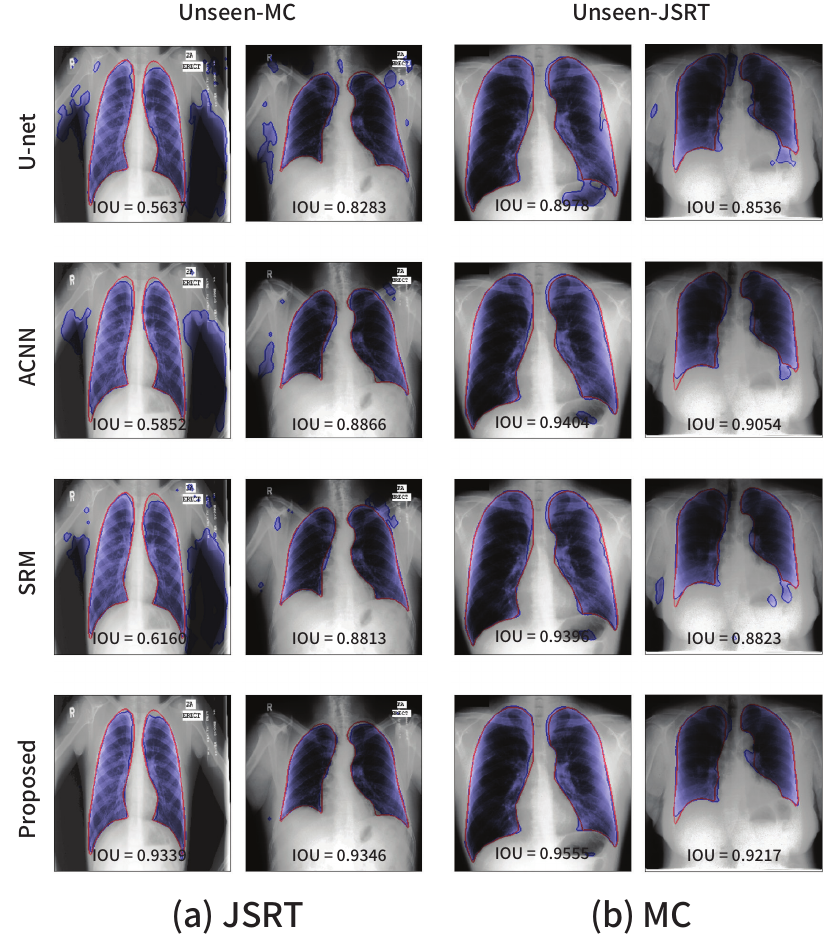
Figure 6. Segmentation results on the lung segmentation task obtained from the models trained using the ( a ) JSRT and ( b ) MC datasets, respectively. The blue color represents the segmentation results, and the ground-truth is in